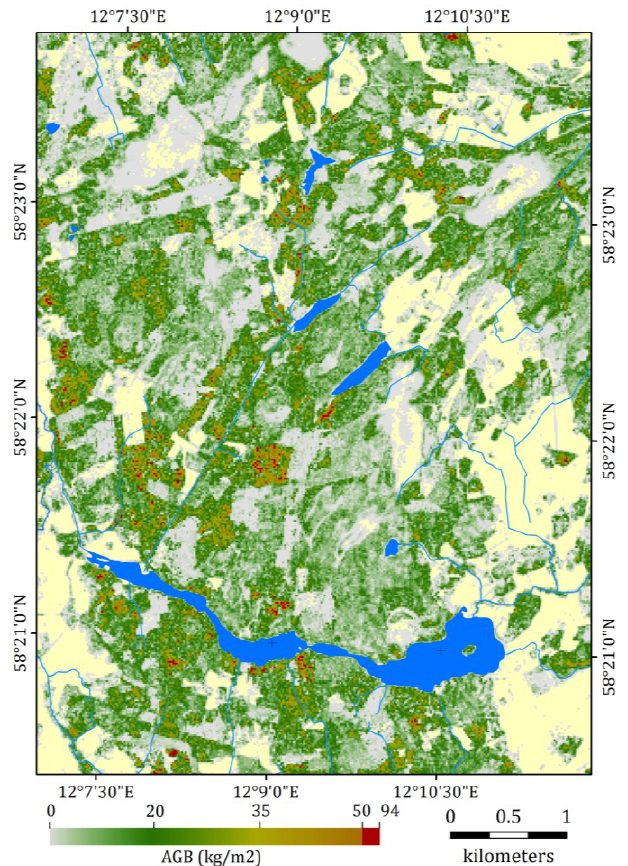
Figure 8. Aboveground biomass map for June 2011 over the SRC area based on the grid-based approach with 3 m × 3 m cell size (within plot R 2 = 0.80, 15 m pixel